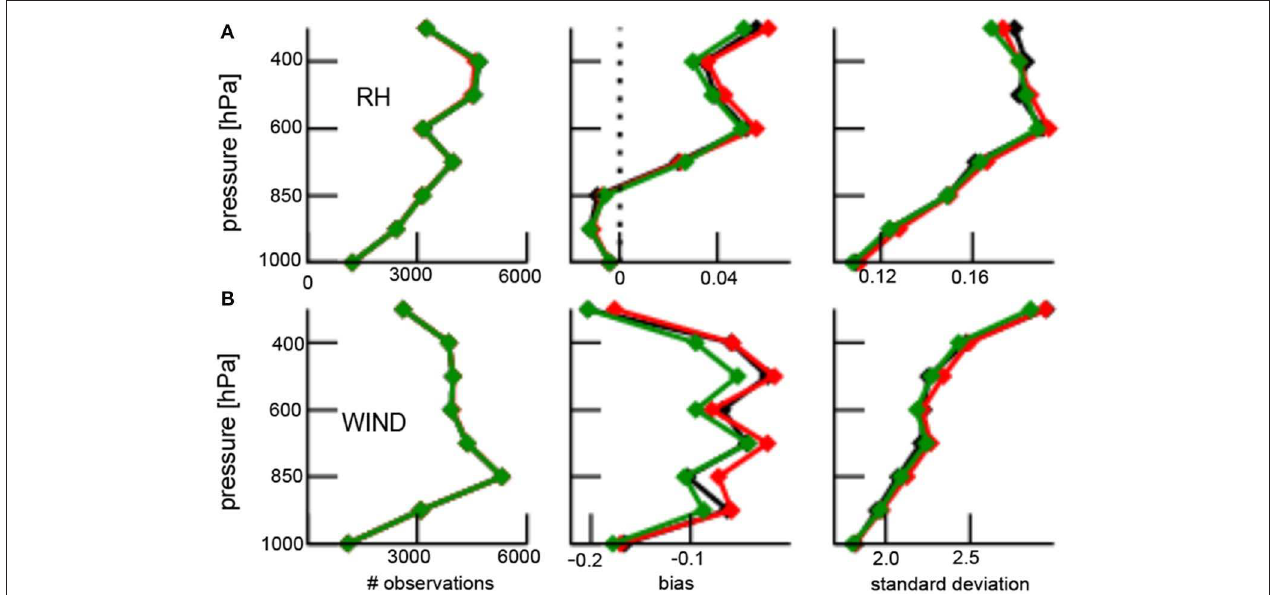
FIGURE 8 | Deterministic first guess departure statistics of upper-air radiosonde relative humidity [RH, panel (A) ] and radiosonde wind speed [WIND, panel (B) ] in summer period 2016 for all used radiosonde observations. The left panels give the number of active observations; the bias is the mean difference between model equivalent first guess and observations (center panel), the standard deviation (right panels) is defined accordingly. The colors decode the NO-SEVIRI run (black), the SEVIRI-CONV run (red) and the SEVIRI-NEW run (green).